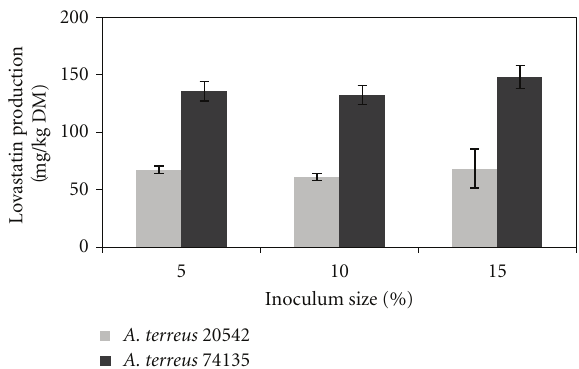
Figure 10: E ff ect of inoculums size on lovastatin production by A terreus ( P > 0 .